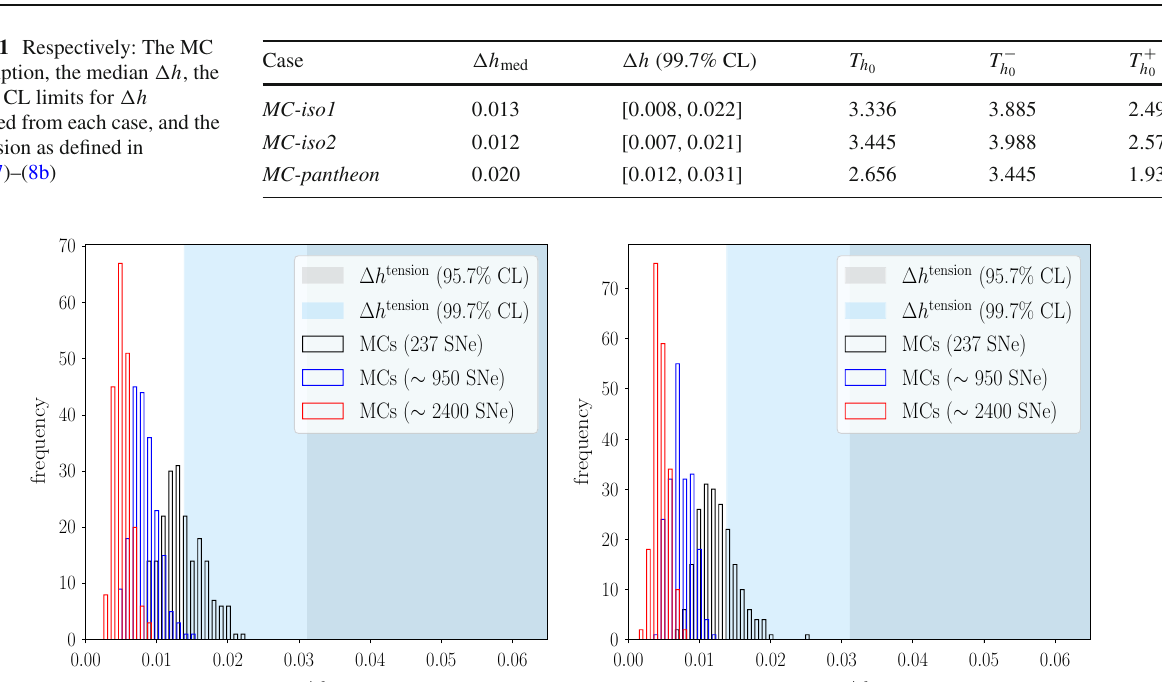
instead. The light gray and blue shades are the same as Fig. 2, but (cid:6) h was clipped at 0 . 05 to ease visualization